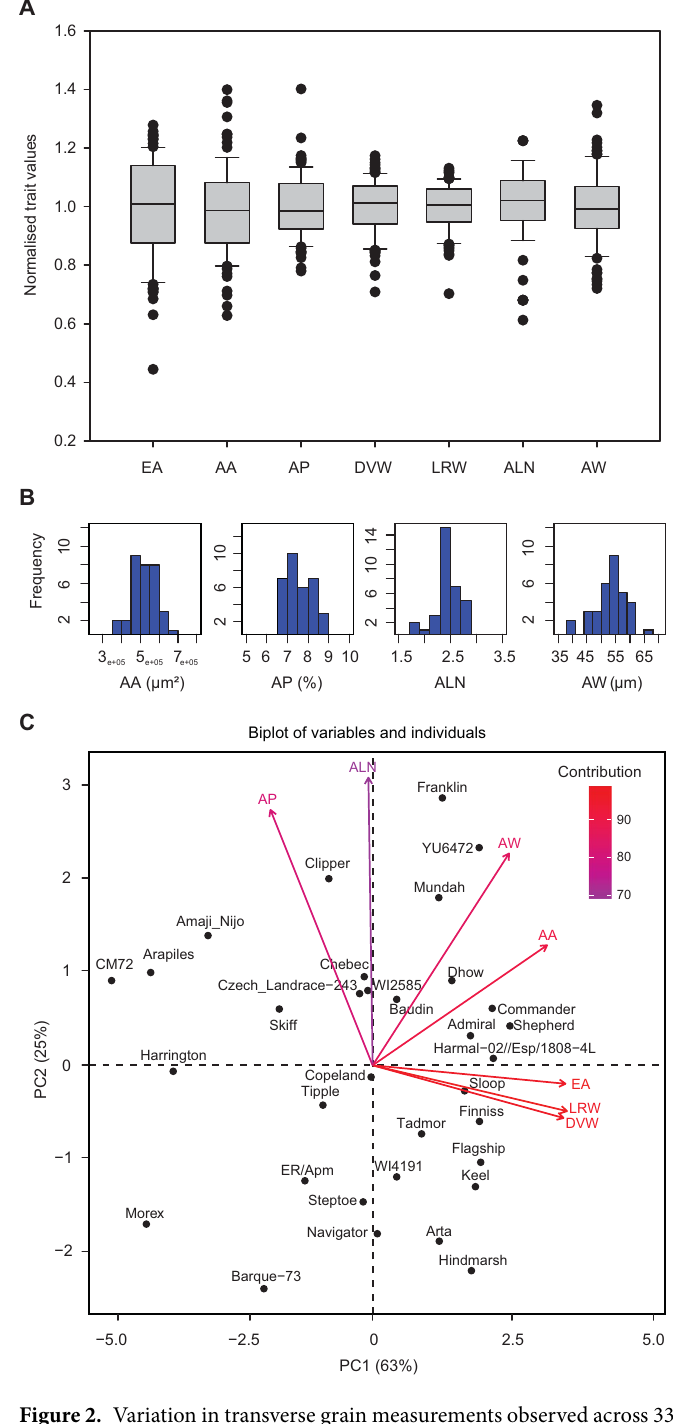
Figure 2. Variation in transverse grain measurements observed across 33 barley genotypes. ( A ) Box plot of normalised data showing the variation in different grain measurements. ( B ) Frequency distribution plots of the four aleurone measurements. ( C ) Principal Component Analysis separates the genotypes based on the seven transverse measurements (variables). EA, endosperm area; AA, aleurone area; AP, aleurone proportion; DVW, grain dorsal-ventral distance; LRW, transverse grain left-right width; ALN, aleurone layer number; AW, aleurone